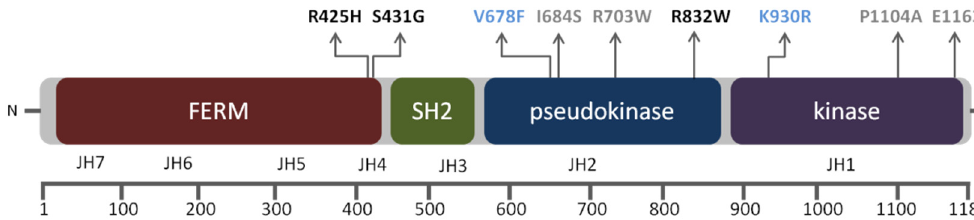
Figure 1. Schematic representation of structural and functional domains of tyrosine kinase 2 (TYK2)